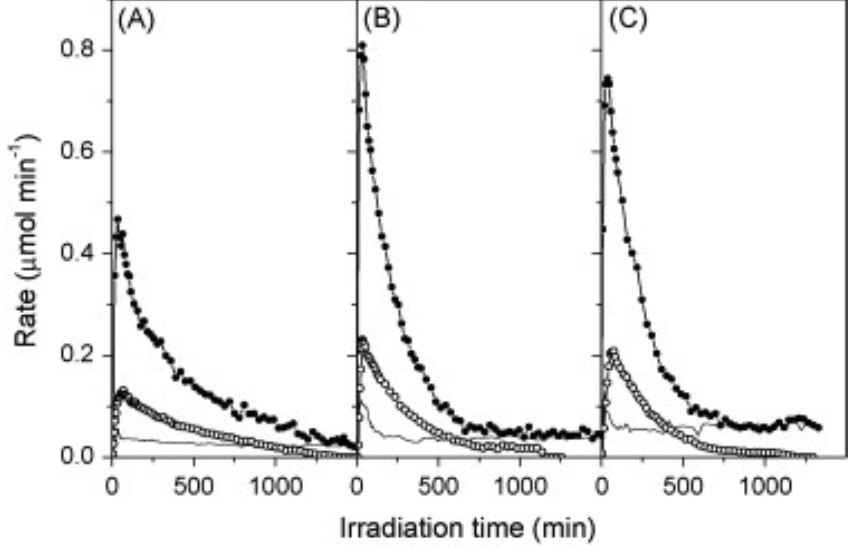
Figure 23. H 2 (full circles) & CO 2 (closed circles) evolution during liquid-phase (0.37 mM) aqueous glycerol reforming at ( A ) 40 °C; ( B ) 60 °C; ( C ) 80 °C (reproduced from [291] with permission of